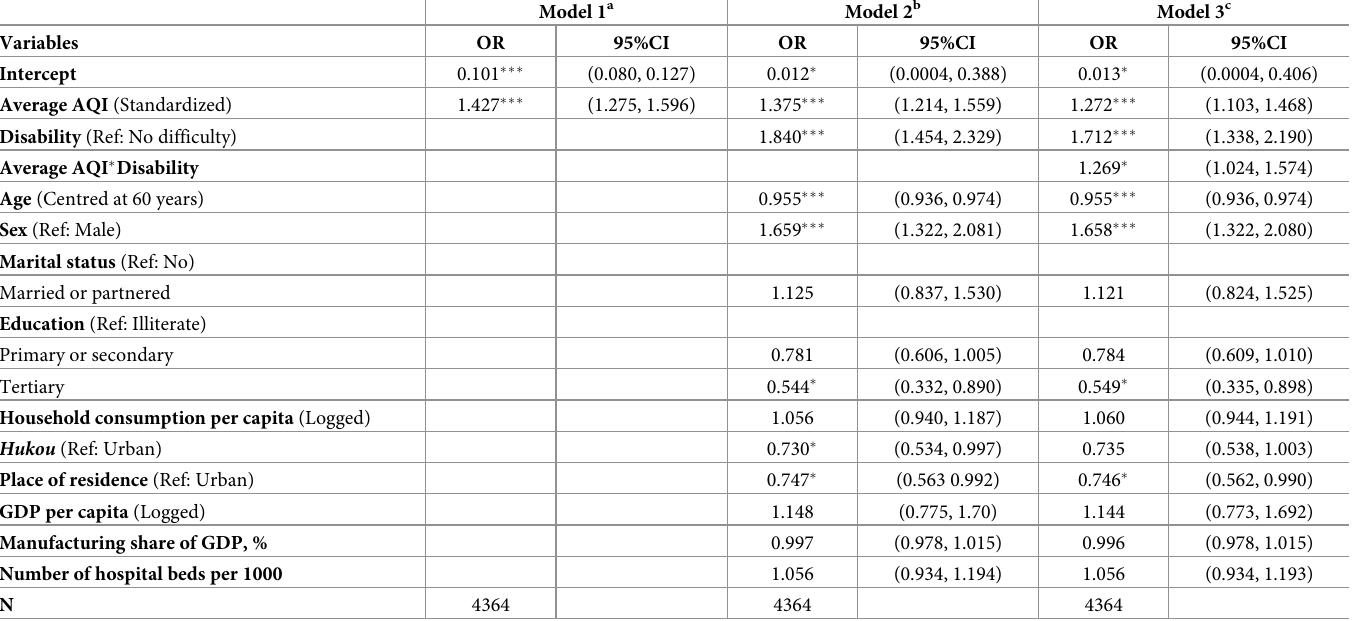
Table 2. Regression results (Odds ratio and 95%CI) for the association between air pollution and general obesity among older people from the China Health and Retirement Longitudinal Study